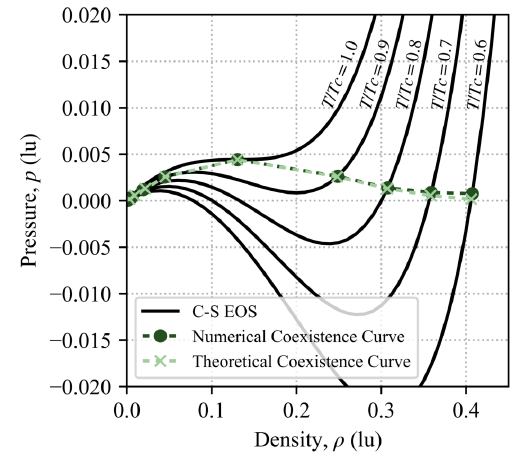
Figure 1. Comparison of the numerical (multiphase LBM sim- ulation) and theoretical coexistence curves for the C-S EOS at di ff erent T / T c